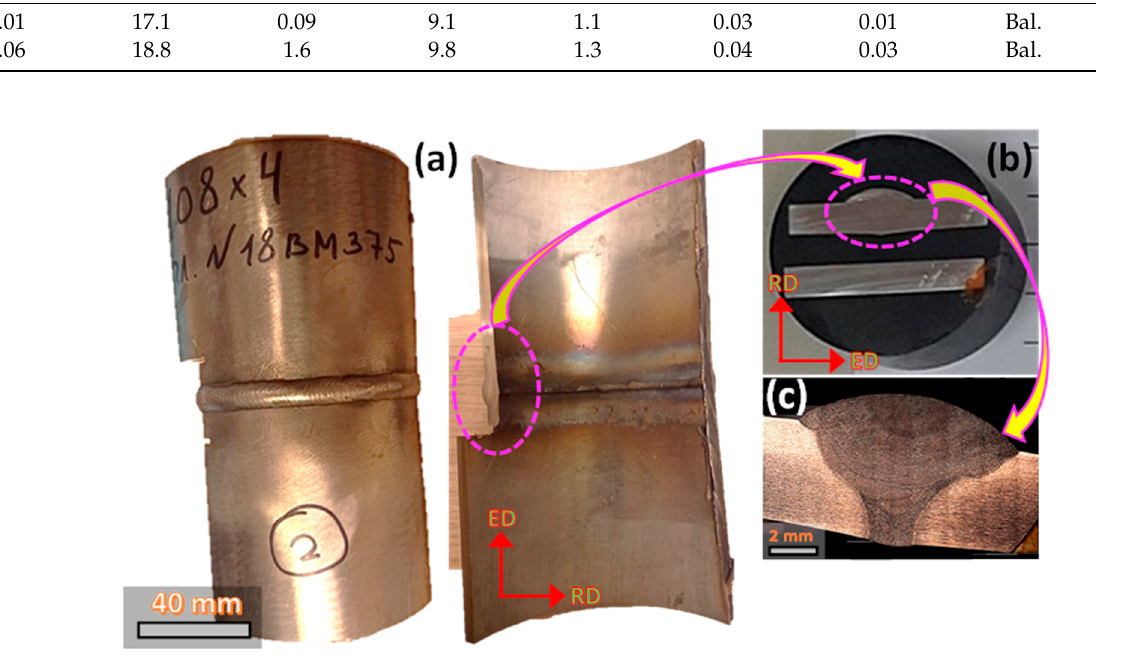
Figure 1. ( a ) welded tube, ( b ) welded seam section, and ( c ) welded seam microstructure.